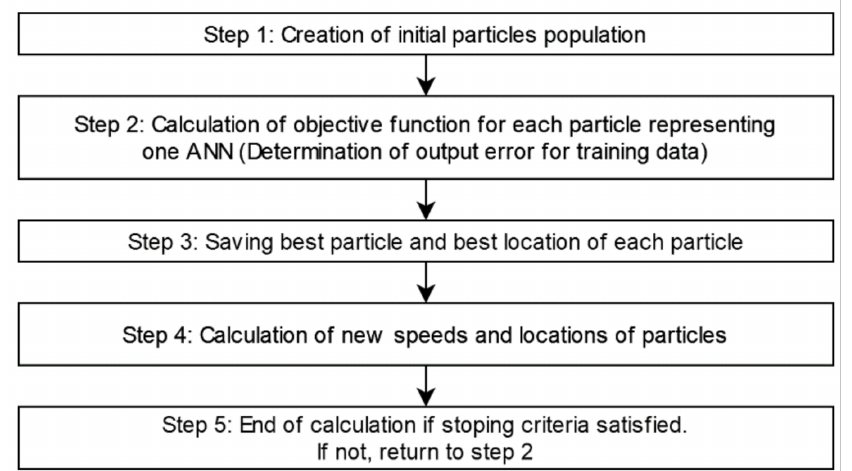
Figure 8. General algorithm of particle swarm optimization artificial neural network